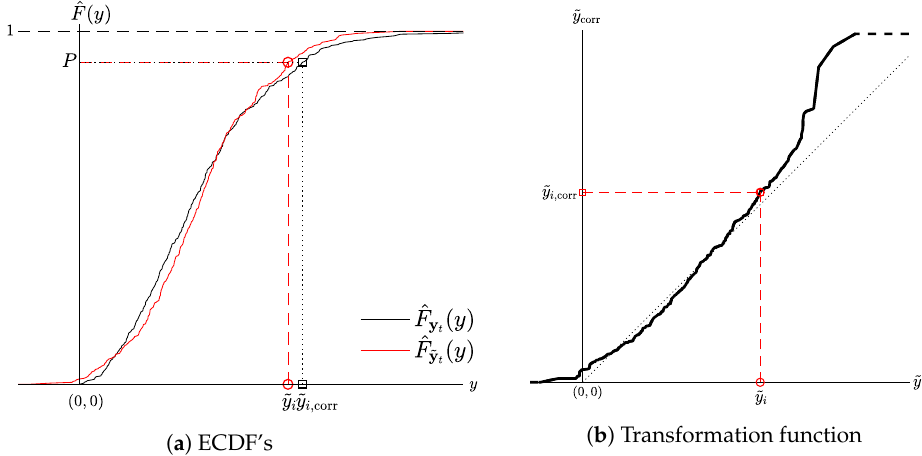
( y ) , and of the raw predictions, t to ˜ y in i i ,corr